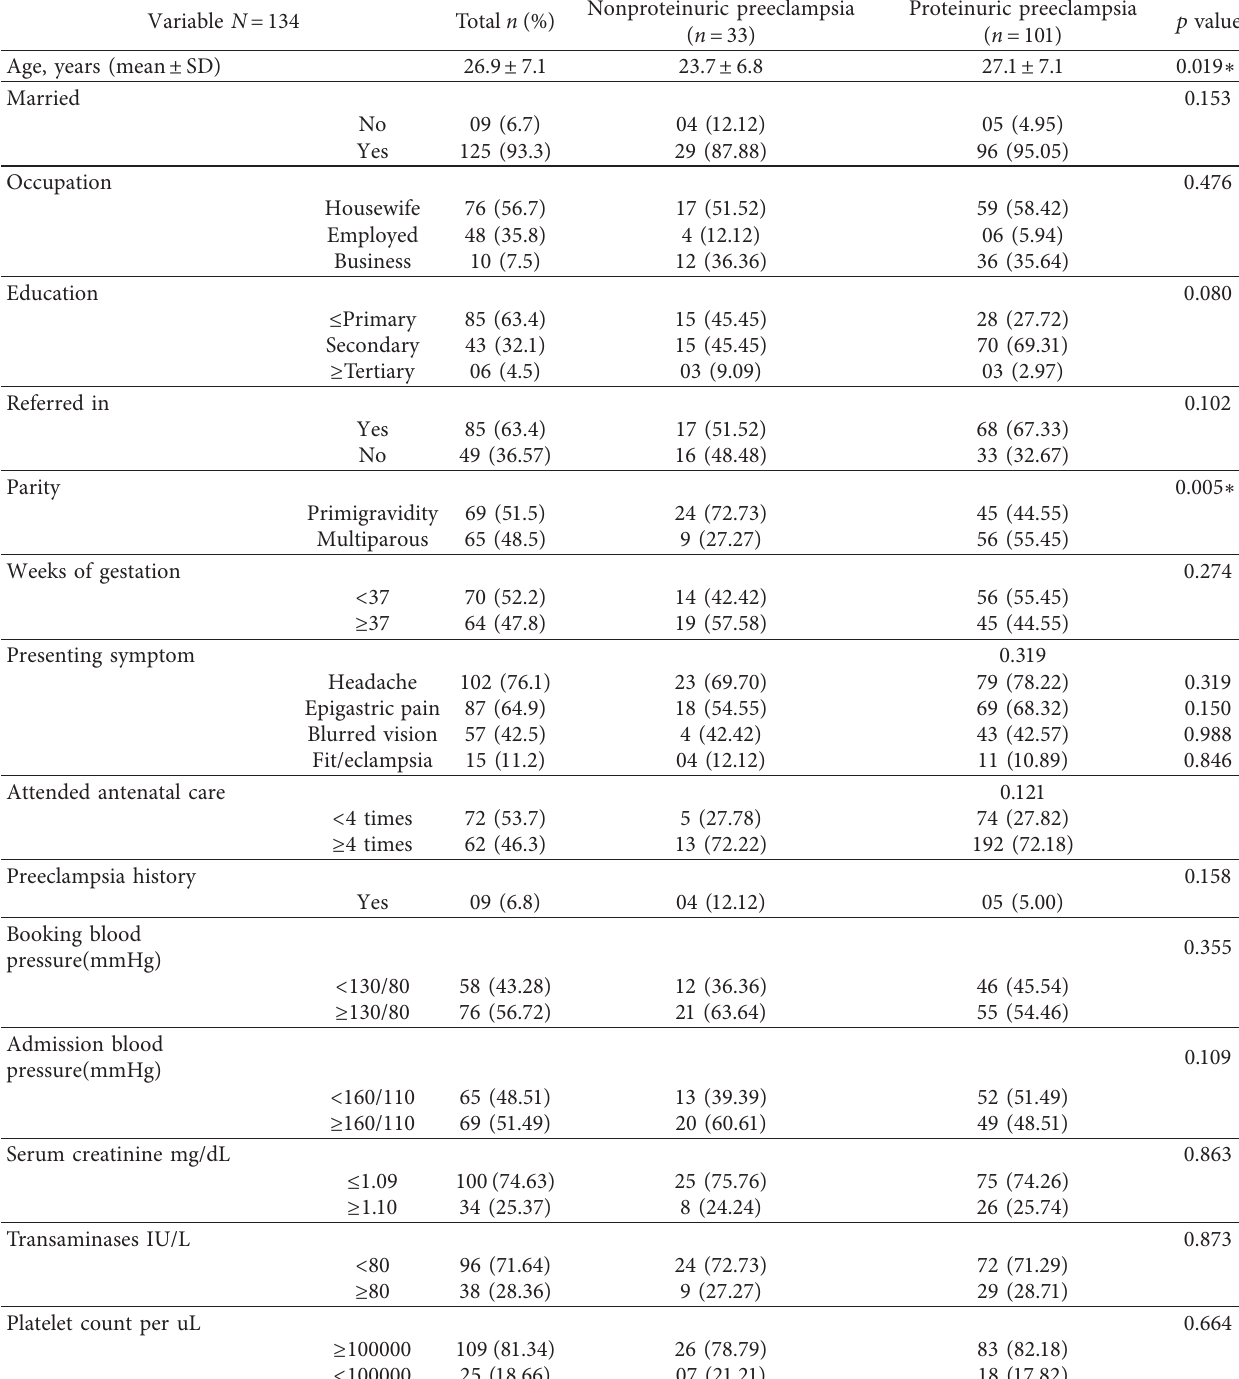
Table 1: Demographic and obstetric characteristics of women with hypertensive disorders of pregnancy at Mbarara Regional Referral Hospital,